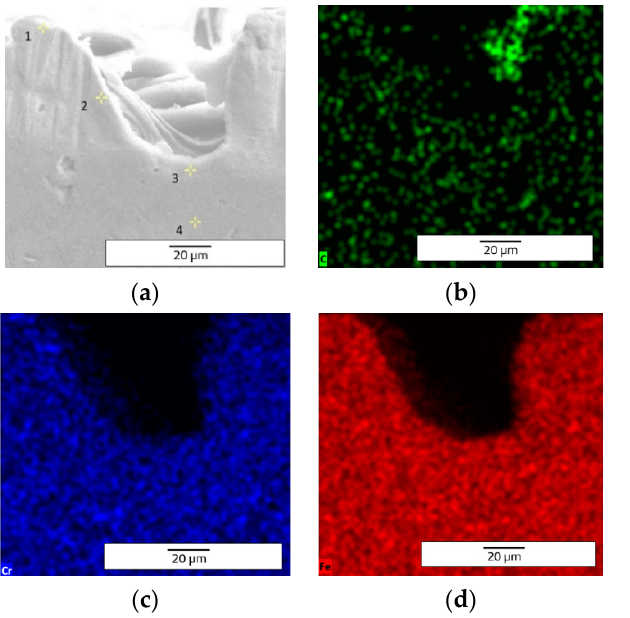
Figure 8. EDX elemental analysis of microtextured design octagonal donut shape (design type A) image of measurement points ( a ) and elemental mapping images ( b —C, c —Cr, d —Fe).